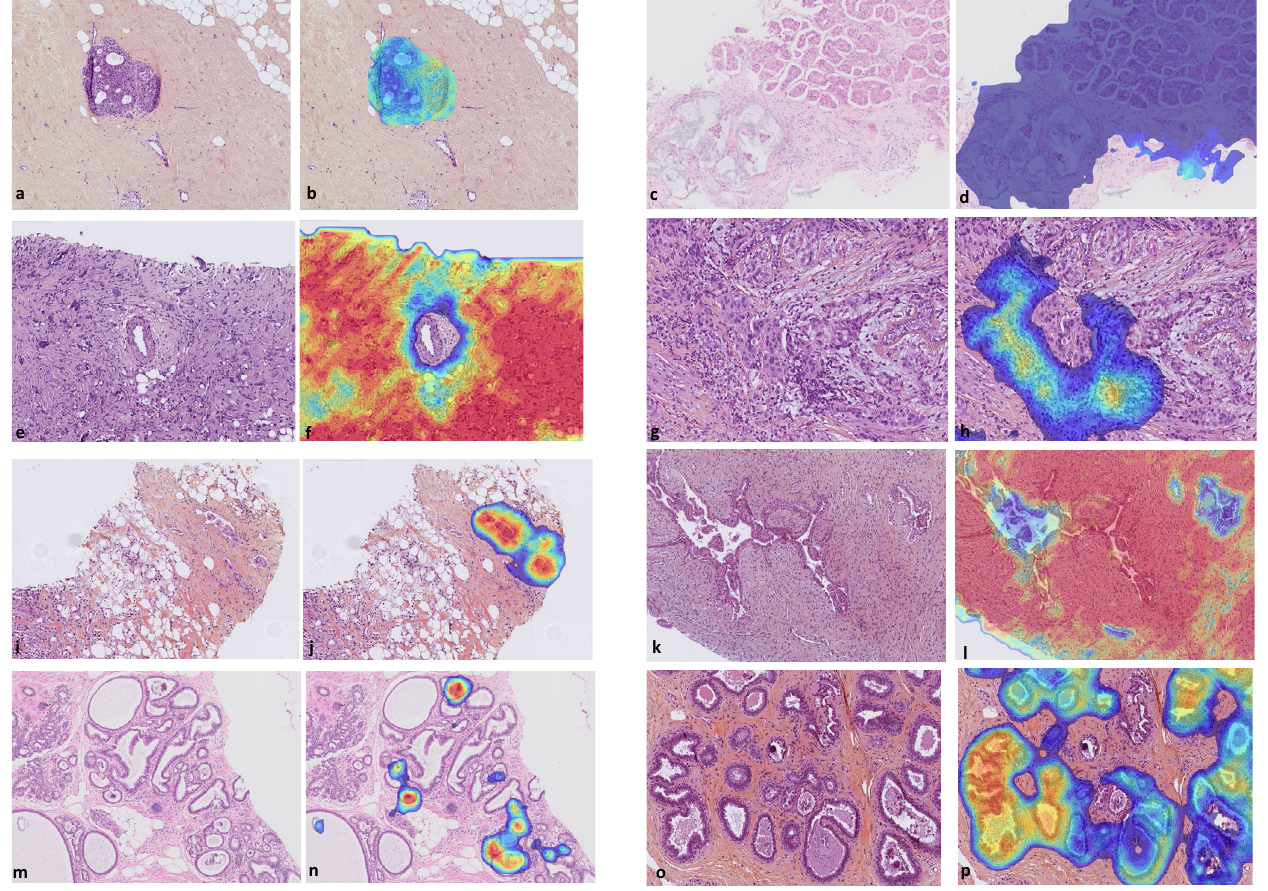
Fig. 2 Examples of tumors and benign features identi fi ed by the AI algorithm. a Macrobiopsy showing atypical ductal hyperplasia focus at 8x (1.25 μ m/pixel) magni fi cation; b Same focus with algorithm DCIS low grade /ADH vs. DCIS high grade heatmap detecting ADH with high probability (where blue shows DCIS low grade/ADH and red shows DCIS high grade); c Tru-cut biopsy showing both invasive mucinous and micropapillary patterns at 8x (1.25 μ m/pixel) magni fi cation; d Same focus with IDC vs. ILC cancer heatmap detecting both subtypes (where blue indicates high probability for IDC and red for ILC); e , f Tru-cut biopsy with metaplastic carcinoma, detected by the algorithm with the invasive cancer heatmap at 10x (1 μ m/pixel); g , h Tru-cut biopsy with IC-NST showing a focus of heavy lymphocytic in fi ltration, detected by the algorithm with the TILs heatmap at 16x (0.625 μ m/pixel); i , j Tru-cut biopsy with IC-NST showing a focus of angiolymphatic invasion (ALI), detected by the ALI heatmap at 10x (1 μ m/pixel); k , l Tru-cut biopsy with phyllodes grade I tumor, detected by the algorithm with the biphasic tumor heatmap displayed at 8x (1.25 μ m/pixel); m , n Vacuum-assisted biopsy showing microcalci fi cations, detected by the algorithm with microcalci fi cations heatmap at 16x (0.625 μ m/pixel); o , p Macrobiopsy with columnar cell changes, detected by the algorithm with columnar cell changes heatmap at 10x (1 μ m/pixel). Slides were stained with H&E or HES. Heatmaps display low probability in blue and high probability in red, unless otherwise speci fi ed. ADH atypical ductal hyperplasia, DCIS ductal carcinoma in situ, IDC invasive ductal carcinoma, TILs tumor- in fi ltrating